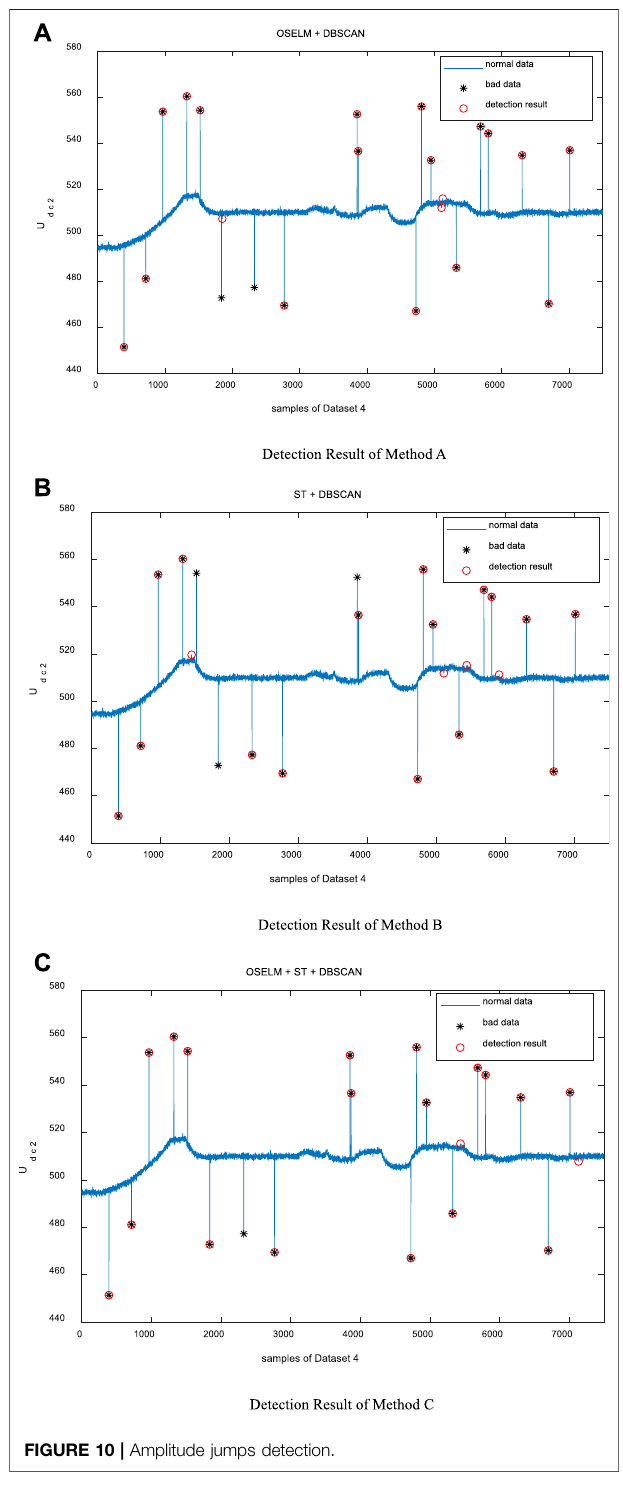
FIGURE 10 | Amplitude jumps